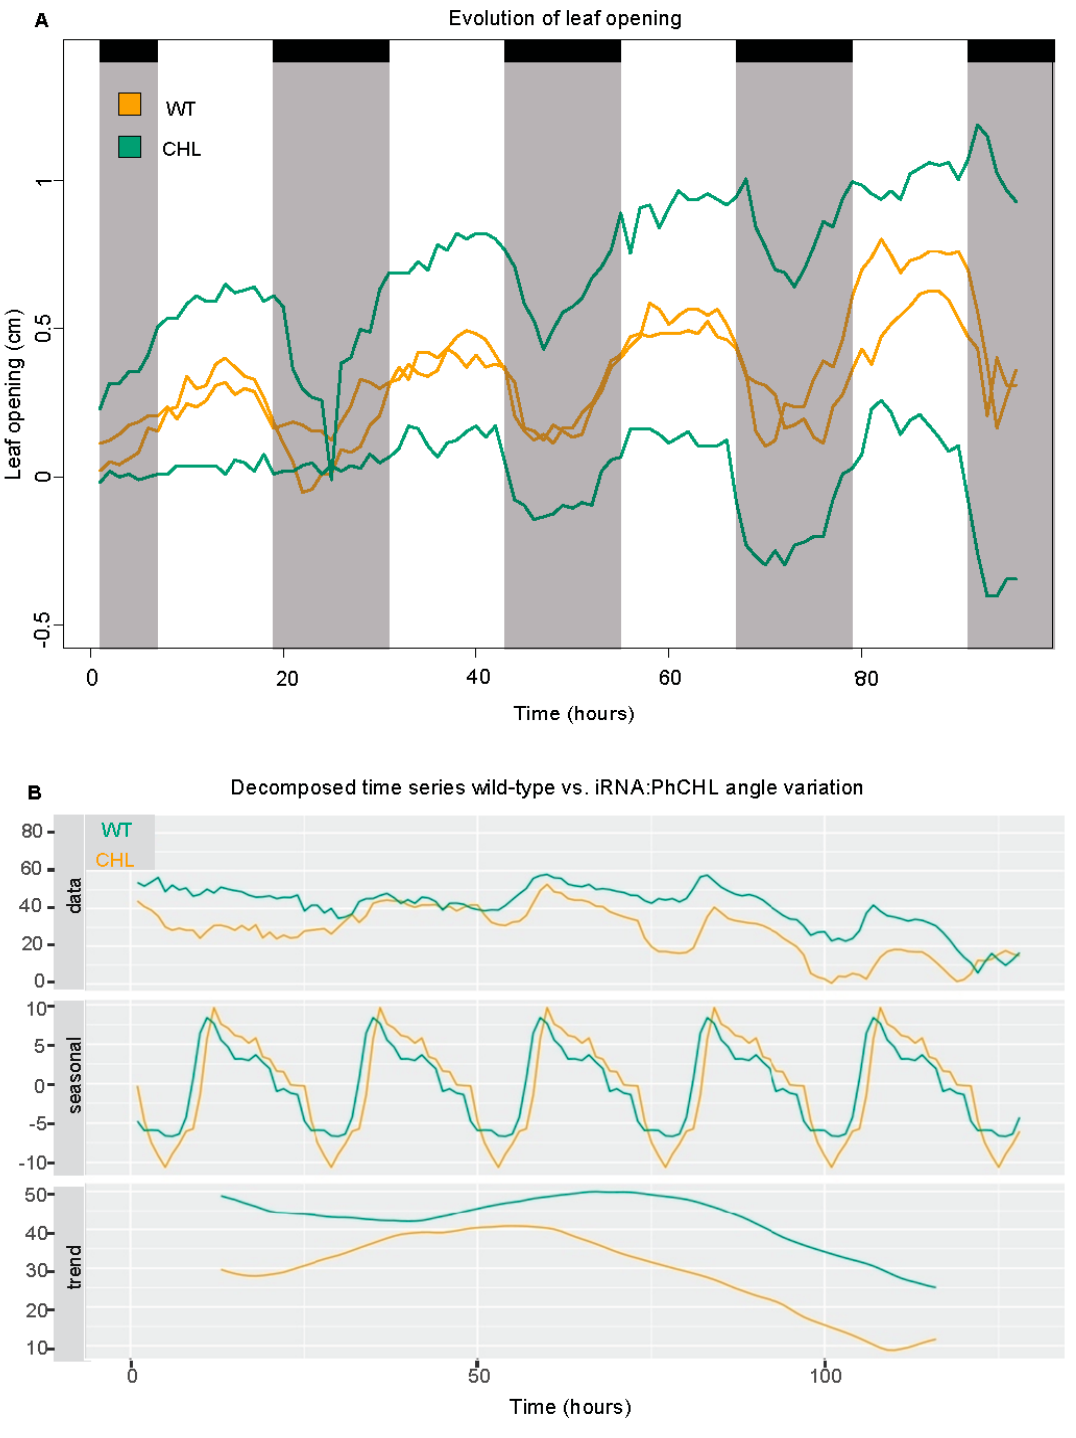
Figure 3. Down regulation of PhCHL does not affect leaf movement ( A ) The distance between the center of the plant and the end of each leaf is shown. Furthermore, these data correspond to the distance in the X axis. Negative values correspond to leaf positions where the tip of the leaf passed the center of the plant. Down regulation of PhCHL causes increased flower angles and advanced daily changes (green line, B ). Orange line represents WT plants, green line represents RNAi:PhCHL plants.